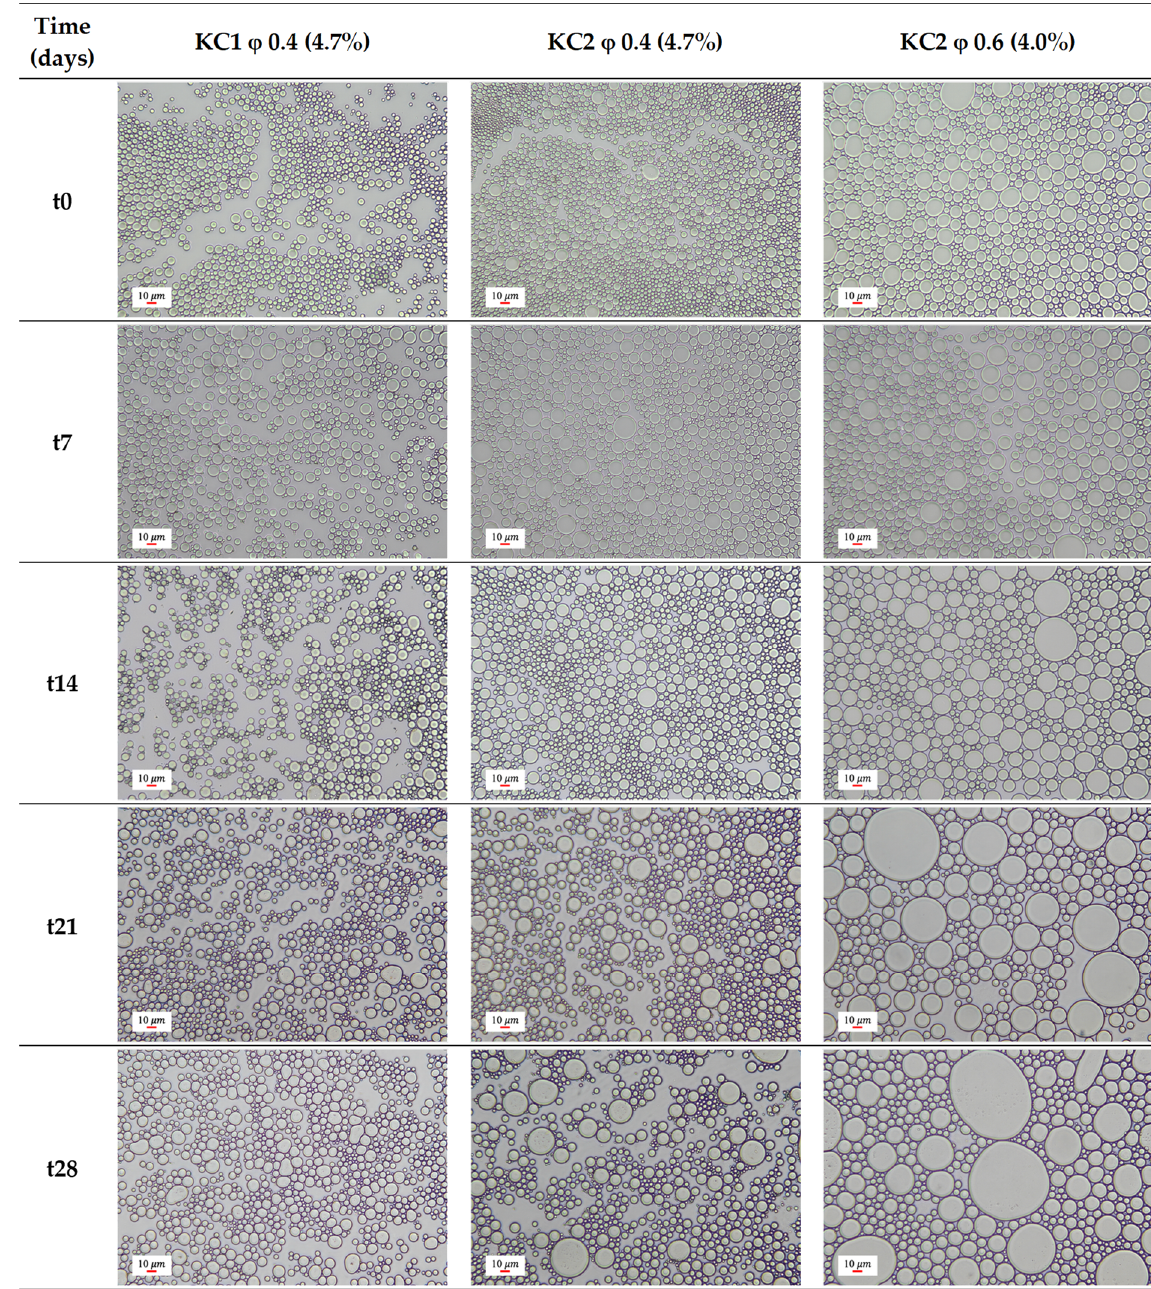
Figure 3. Optical microscopy images (200× magnification) of the three produced Pickering emulsions (KC1 φ 0.4 (4.7%), KC2 φ 0.4 (4.7%), and KC2 φ 0.6 (4.0%)) over time (t0–t28 (days)). Scale bar of 10 µm. Table 3. Droplet size of the produced Pickering emulsions (KC1 φ 0.4 (4.7%), KC2 φ 0.4 (4.7%), KC2 φ 0.6 (4.0%)) over time (t0–t28 (days)).